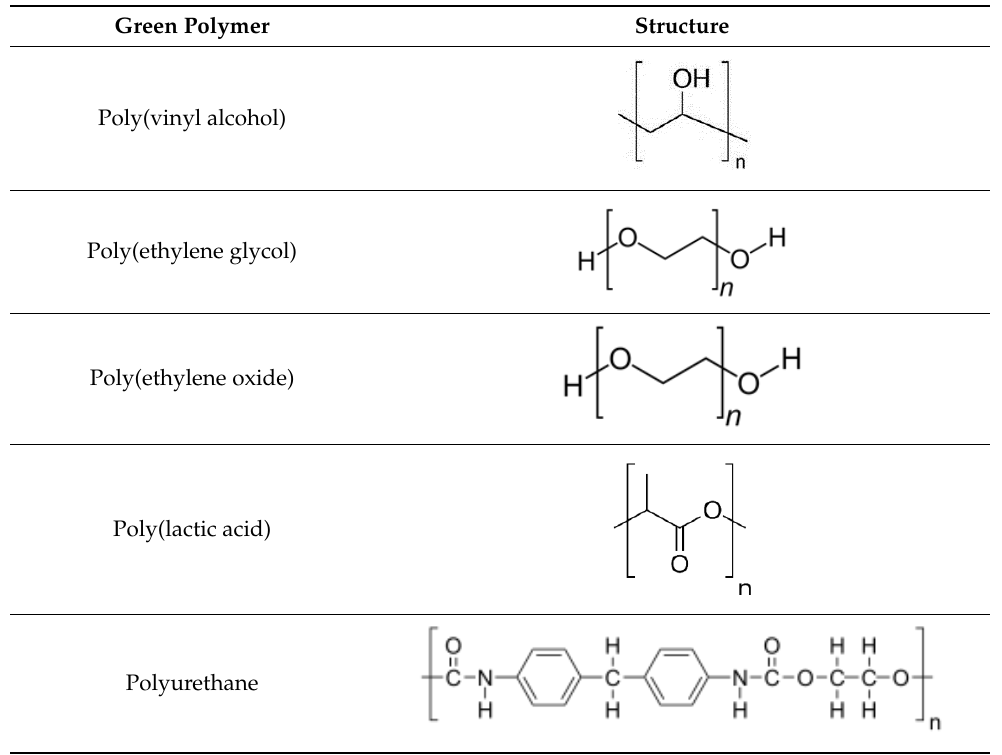
Table 1. Some green synthetic and natural polymers.